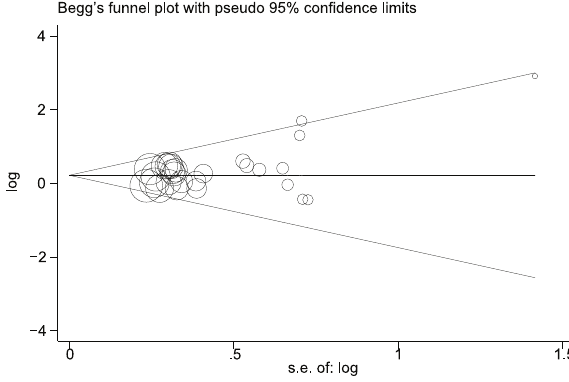
Figure 5. The funnel plot shows that there was no obvious indication of publication bias for the outcome of